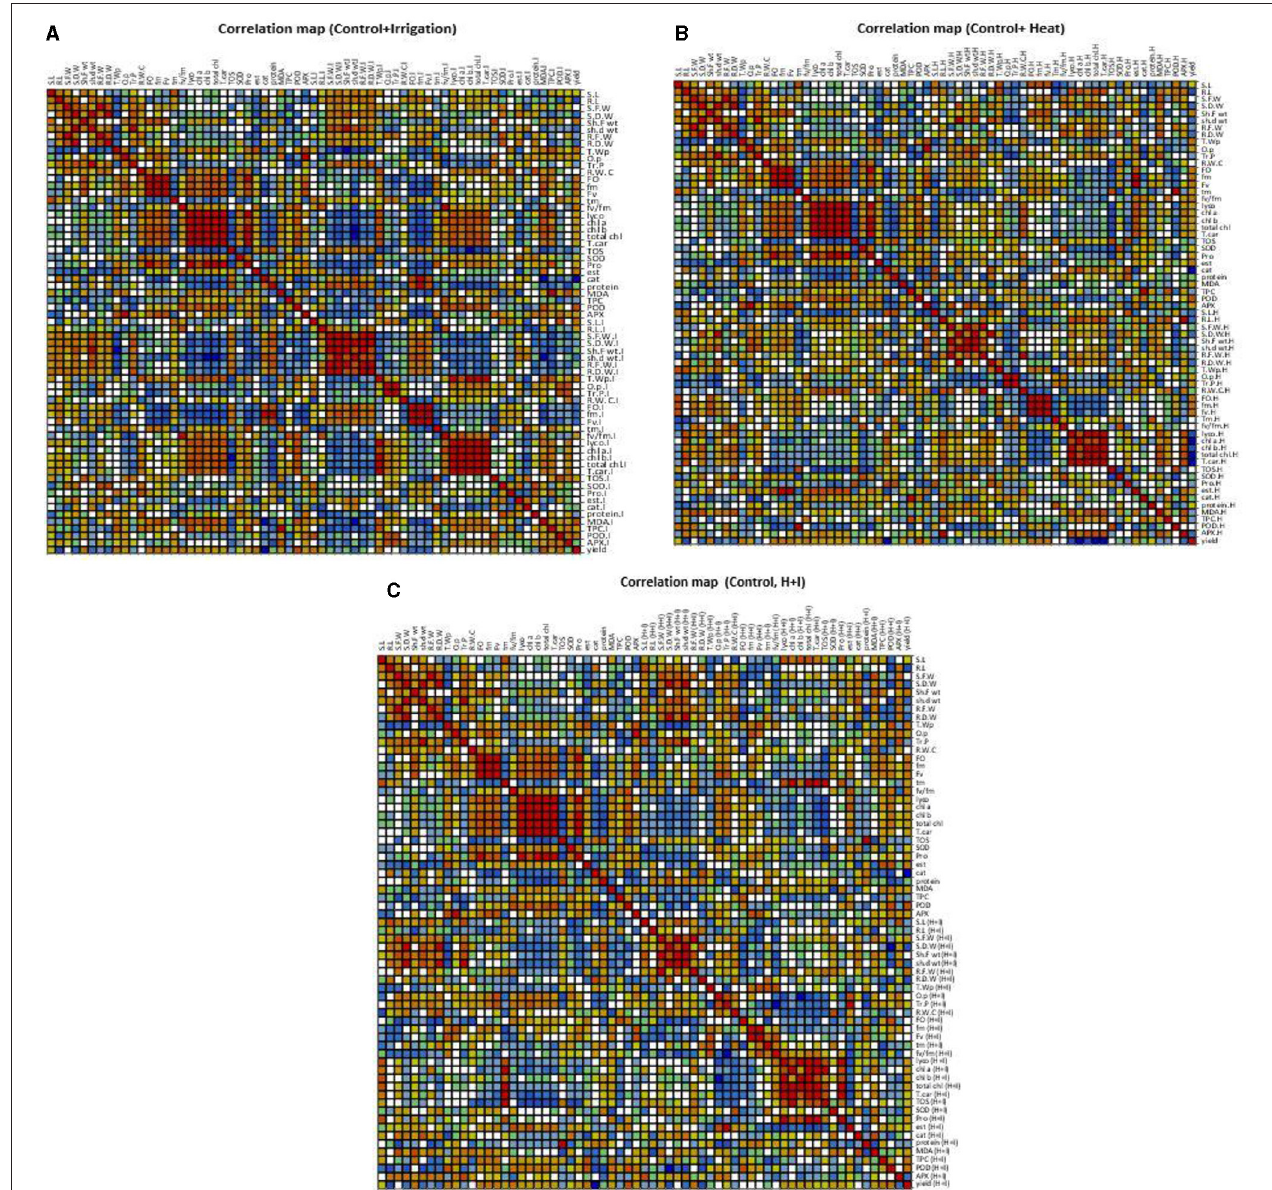
FIGURE 4 | Correlation matrix showing Pearson’s correlation among morphophysiological and biochemical traits in chickpea genotypes under Irrigation and non-stress conditions (A) . Correlation matrix showing Pearson’s correlation among morphophysiological and biochemical traits in chickpea genotypes under Heat and non-stress conditions (B) . Correlation matrix showing Pearson’s correlation among morphophysiological and biochemical traits in chickpea genotypes under Combined stress and non-stress conditions (C)